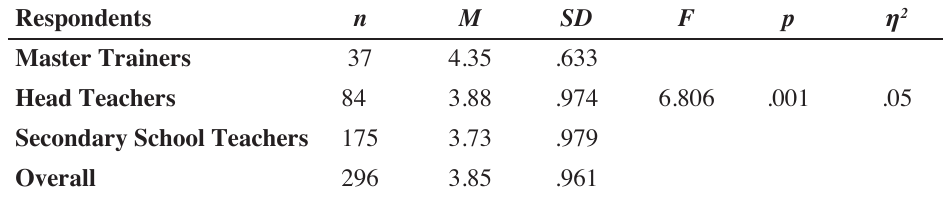
Table.11 Information and communication technology Training is Useful for Teachers’ Personal